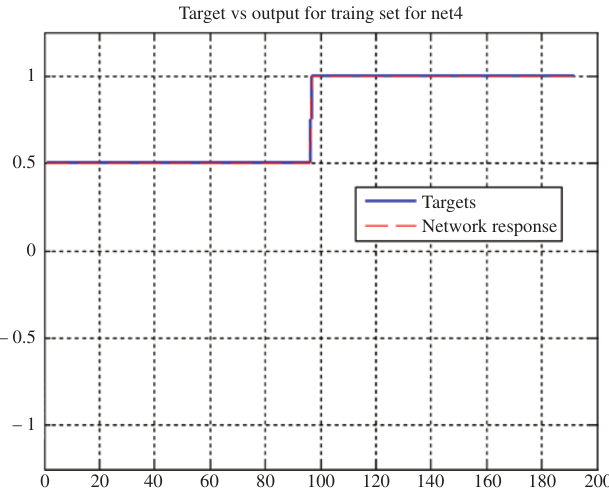
Figure 16: Target vs. Output for Training Data Set for net4.